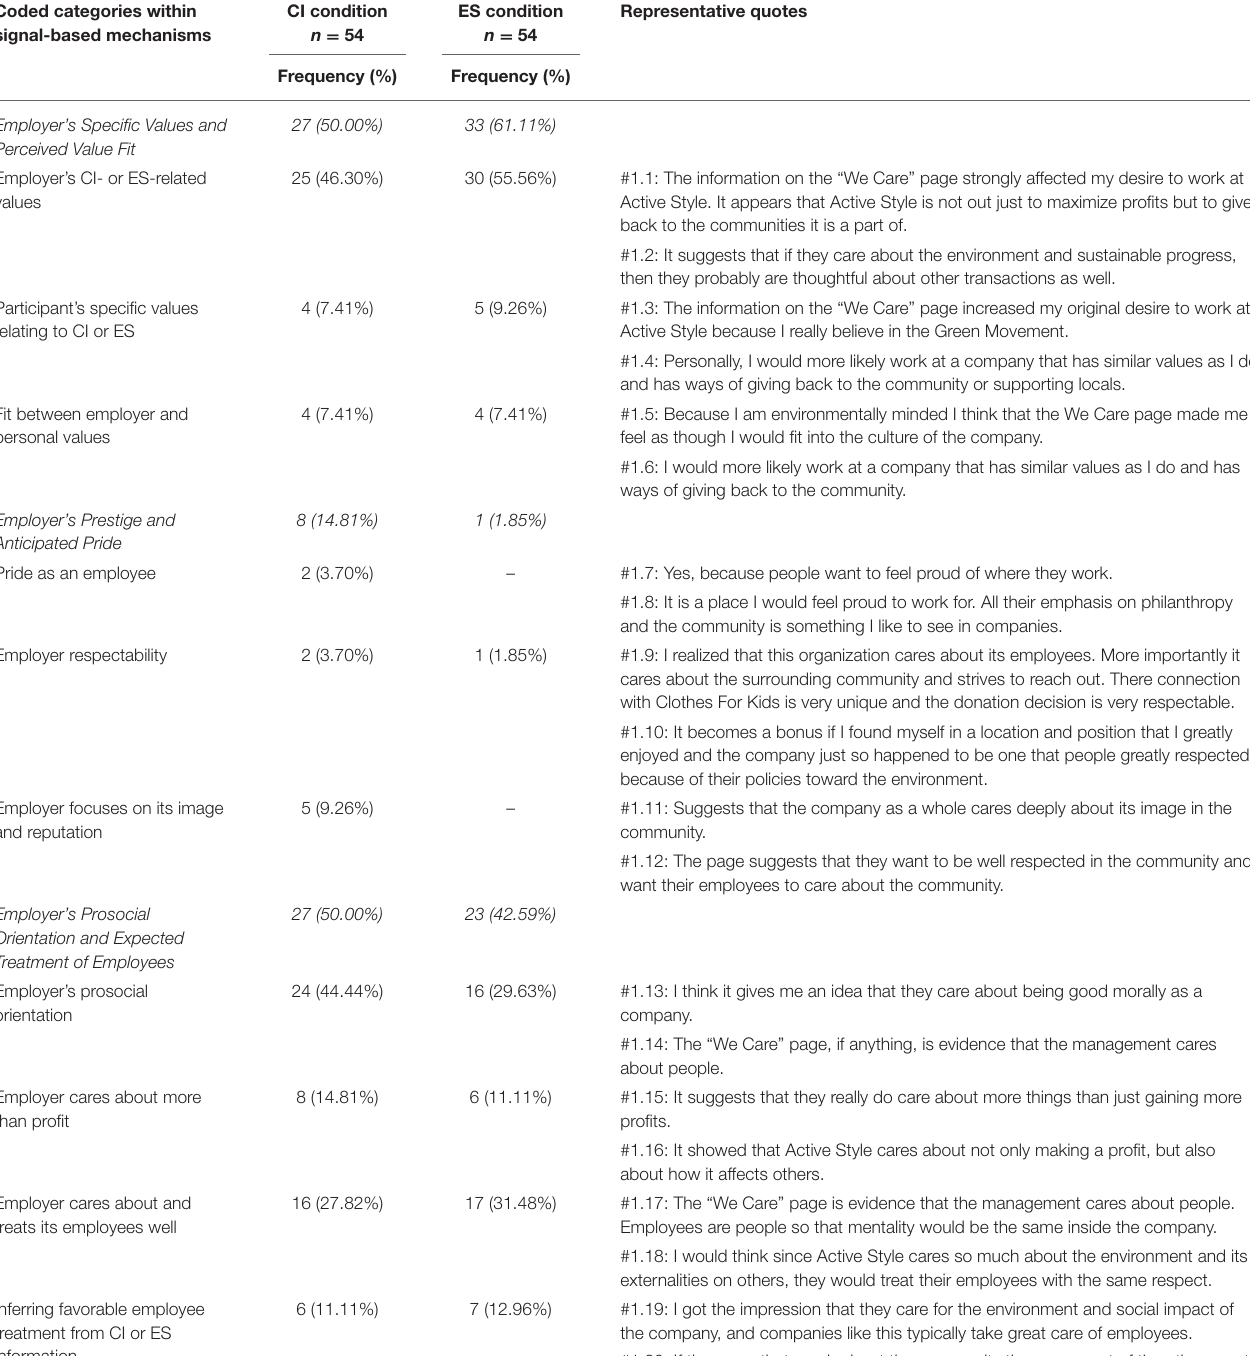
TABLE 1 | Frequencies and Percentages of Responses about an Employer’s Community Involvement (CI) or Environmentally Sustainable (ES) Practices: Explicit Comments Pertaining to Three Signal-Based Mechanisms. Coded categories within signal-based